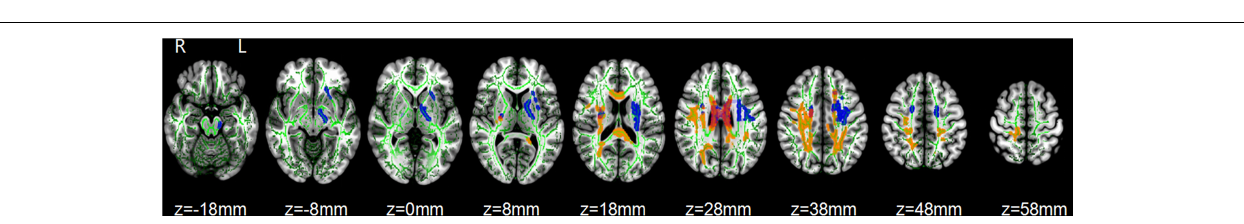
FIGURE 3 | Overlapping patterns of increased MD were found between asymptomatic carriers and patients with CJD. Overlapping areas of increased MD (red code), significant areas of increase MD (blue code) in asymptomatic carriers at follow-up relative to baseline, and significant areas of increased MD (yellow code) in CJD patients versus healthy controls are shown with the skeleton (green